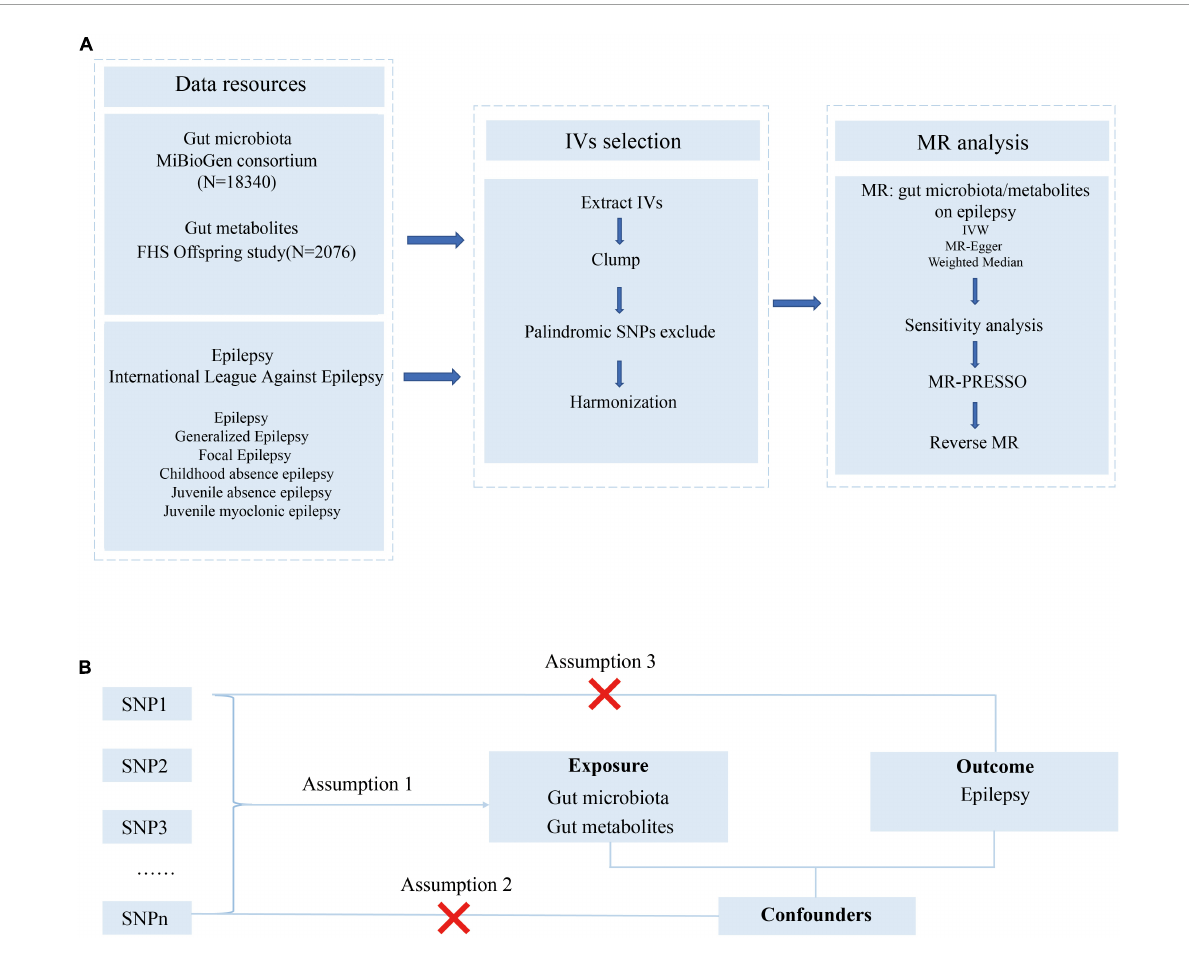
FIGURE1 Study design and Mendelian randomization core assumption. (A) Data resource and study design of our bi-directional MR. (B) Three assumptions in the Mendelian randomization